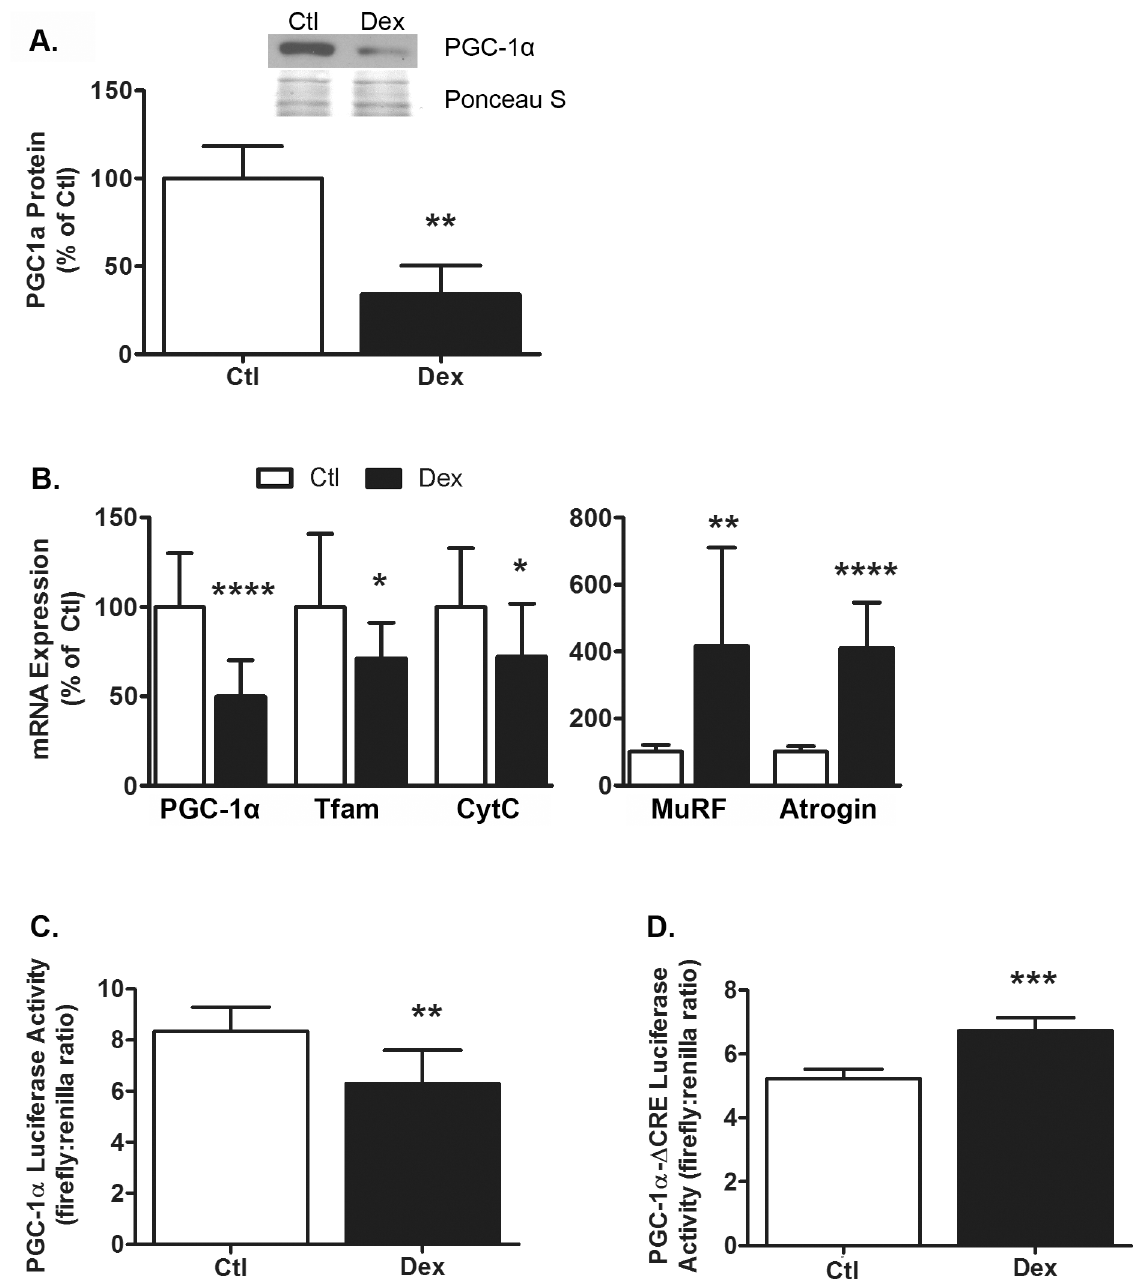
Fig 1. Dexamethasone decreases PGC-1 α protein expression and transcription. (A) Treatment of L6 myotubes with Dex (100nM, 48hrs) decreased PGC-1 α protein expression (p = 0.01). n = 3/treatment from 3 experiments. A representative western blot image and corresponding section of the Ponceau S — stained membrane are shown. (B) Dex decreased the mRNAs for PGC- 1 α (p < 0.0001) and its target genes Tfam (p = 0.03) and CytC (p = 0.03); Dex also increased MuRF-1 (p = 0.003) and Atrogin-1/ MAFbx mRNAs (p < 0.0001). n = 10-14/treatment from 4 – 5 experiments. (C) In L6 cells transfected with a pPGC-1 α -Luc, Dex decreased luciferase activity (p = 0.001). n = 6/treatment from 6 experiments. (D) In separate experiments with cells transfected with a pPGC-1 α - Δ CRE-Luc, Dex increased luciferase activity (p = 0.0005). n = 3/treatment from 3 experiments. Data are expressed as mean values ± s.d. and were analyzed by Student ’ s t -test. Asterisks indicate values that are significantly different from control: p < 0.05 = * , p < 0.01 = ** , p < 0.001 = *** and p < 0.0001 = ****